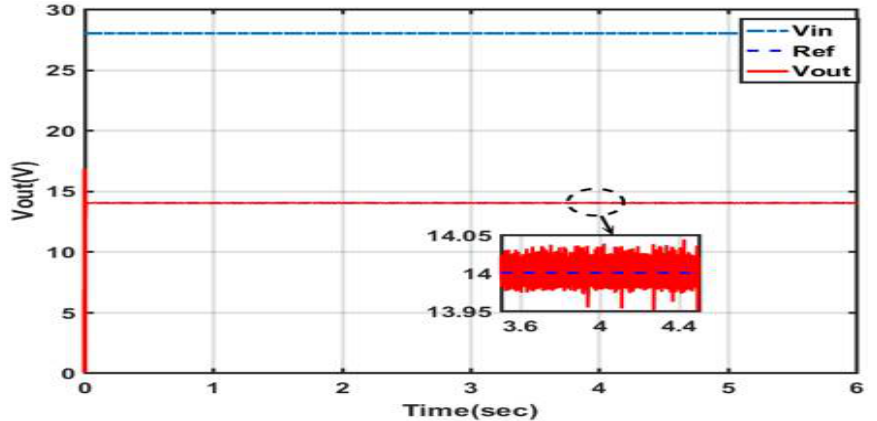
Figure 8. Dynamic response of the buck converter with CPL closed loop mode using RST controller.